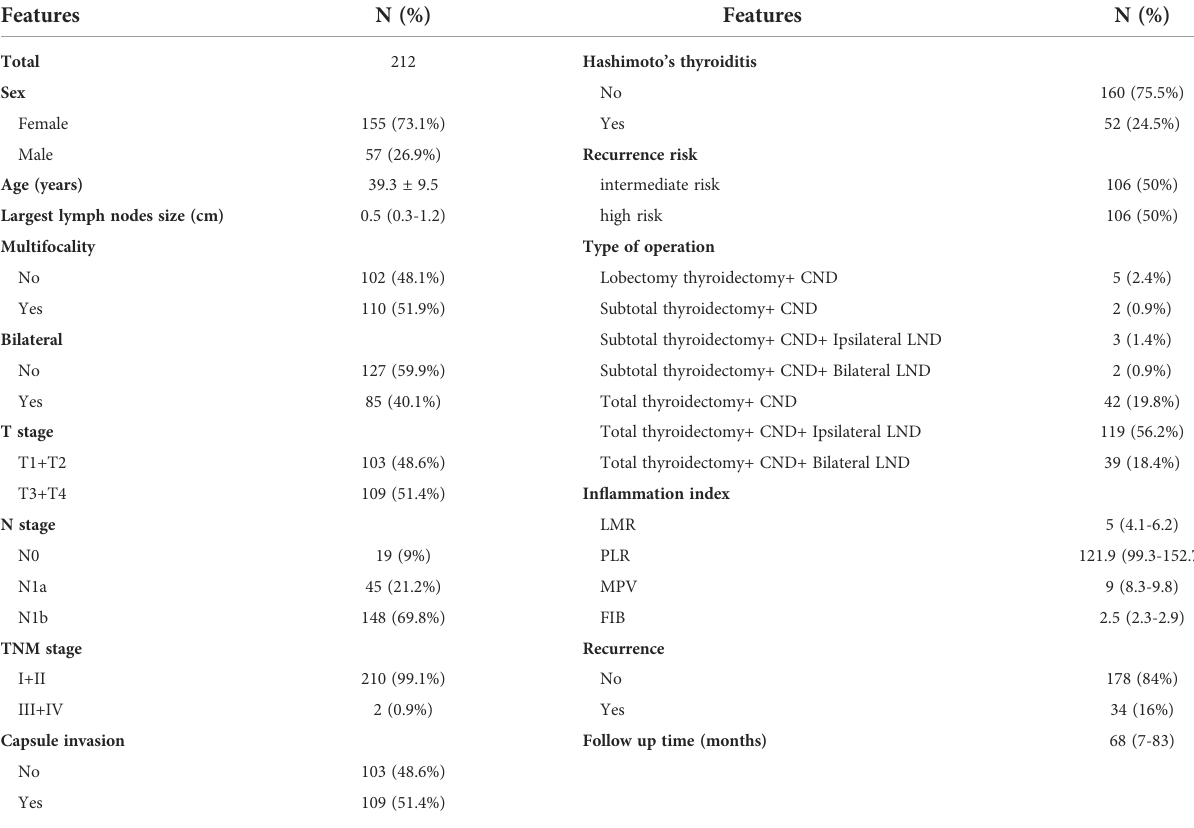
TABLE 1 Baseline clinicopathological features of PTC